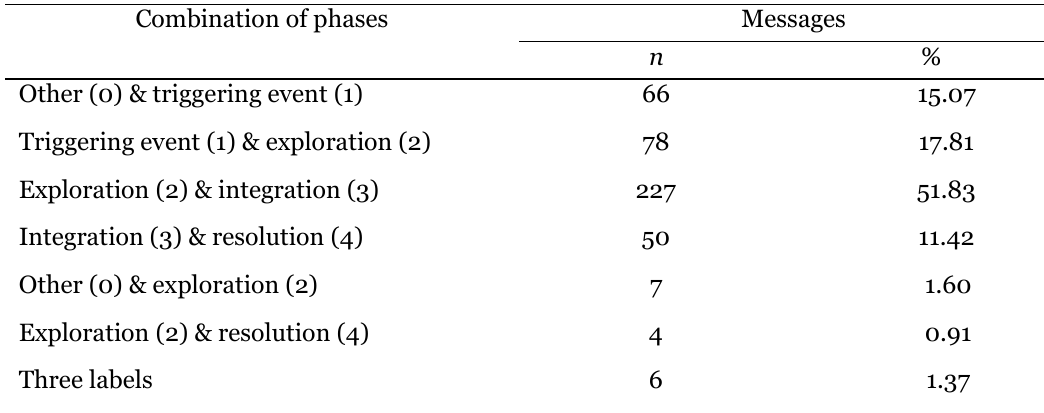
Distribution of